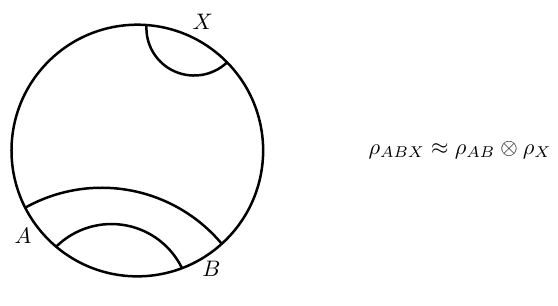
Figure 3 . Boundary subregions whose reduced density matrix approximately